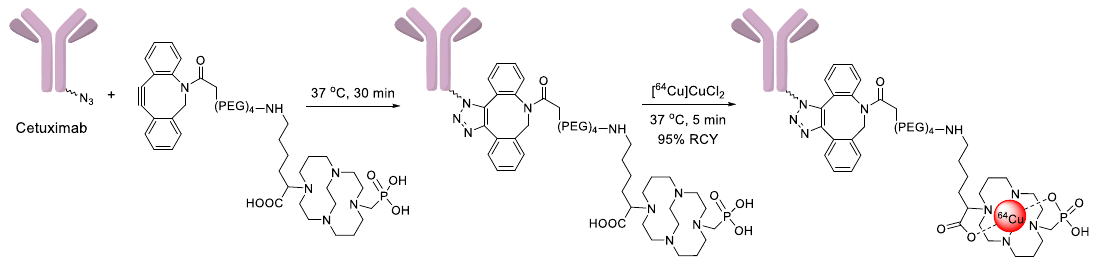
Figure 6. Reaction of azide-conjugated Cetuximab antibody with DBCO-conjugated crossed bridged macrocyclic CB-TE1K1P chelator for 64 Cu radiolabeling.